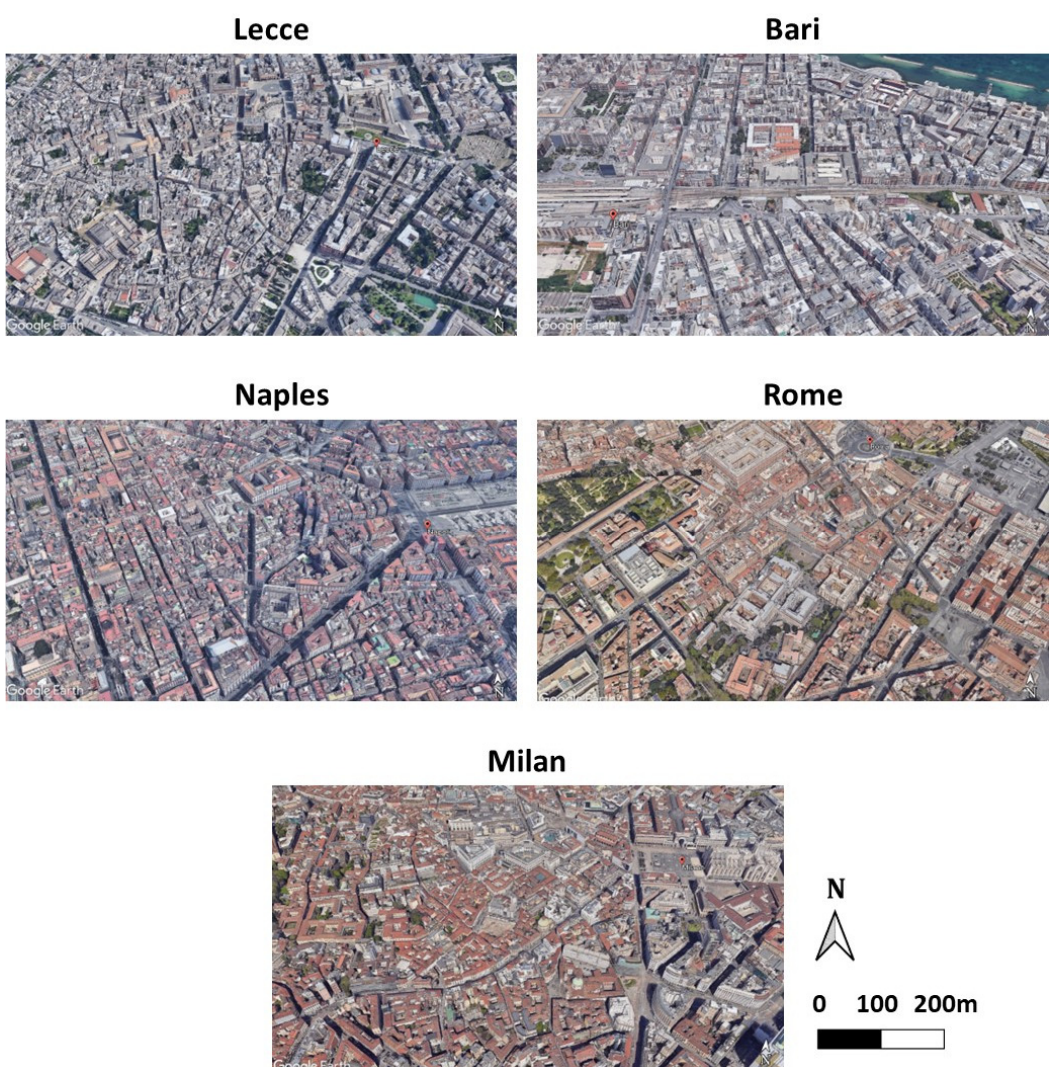
Figure 1. View of typical neighborhoods of the Italian cities investigated (maps from Google Earth